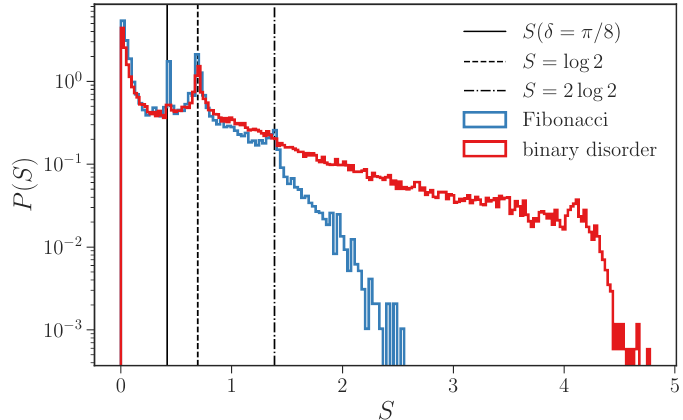
Figure 8: Distribution of the half-chain entanglement entropy, in the MBL phase ( h = 5), with L = 22 sites and around energy density ε = 0.5. For comparison, we superimpose to the Fibonacci case the distribution obtained when shuffling the Fibonacci potentials. Solid line: entropy of the “magic angle” states Eq.